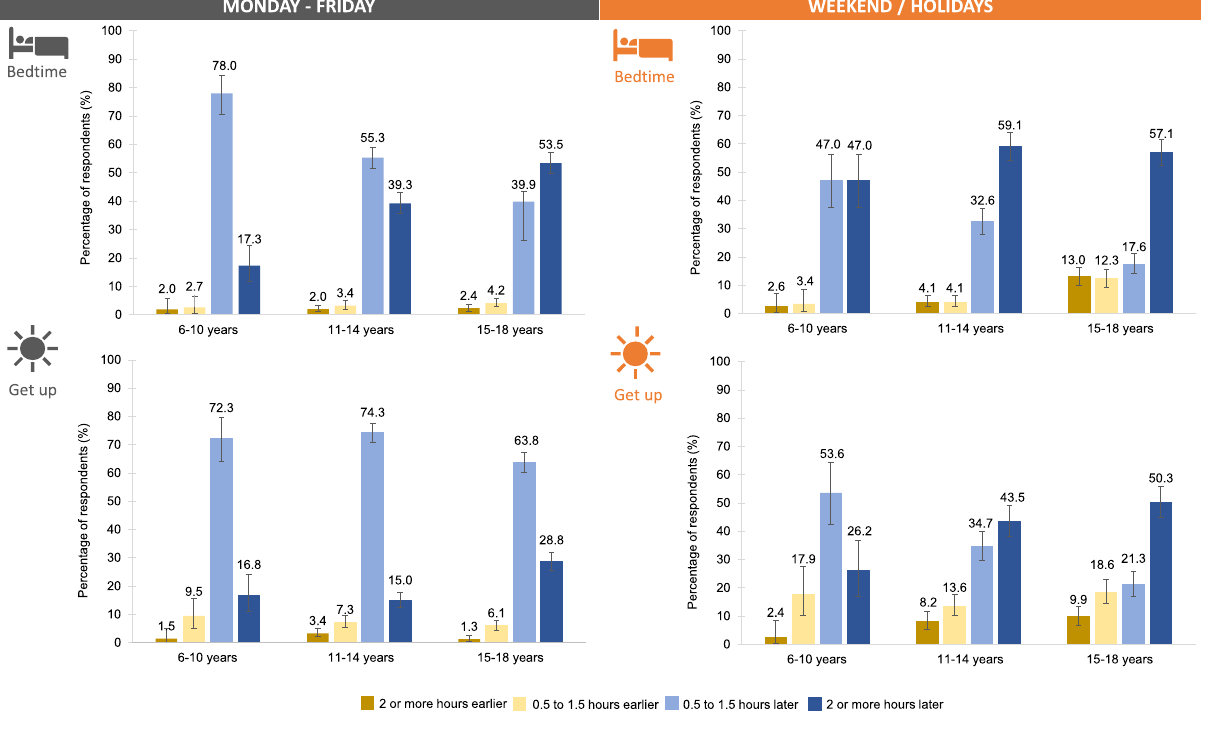
Figure 1. Changes in sleep rhythm. Delay in bed- and wake times in children and adolescents during COVID- 19 compared to before. During the week as well as on weekends (more pronounced), children and adolescents reported later bedtimes. However, wake times, especially at weekdays, were not delayed to the same extent as bedtimes. Additionally, the delay in bed- and wake times increased with age, i.e., 15–18-year-olds reported the strongest